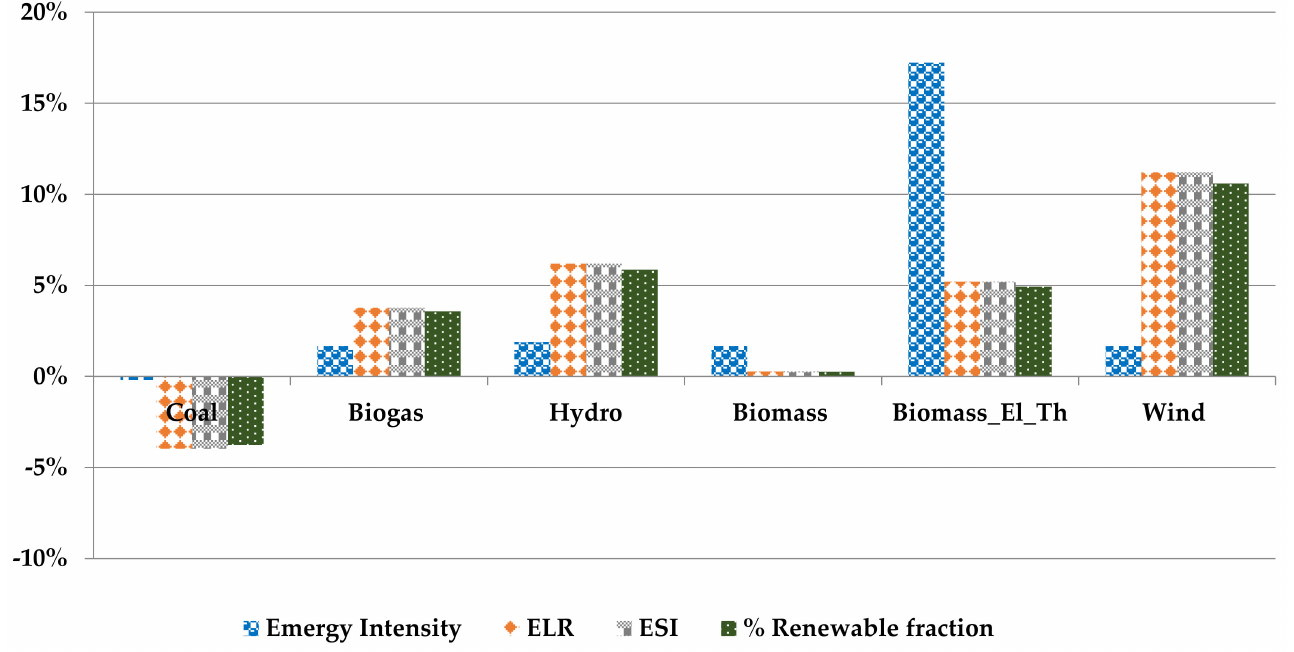
Figure 8. Comparative analysis of emergy flows and emergy-based indicators for the PHA produc- tion